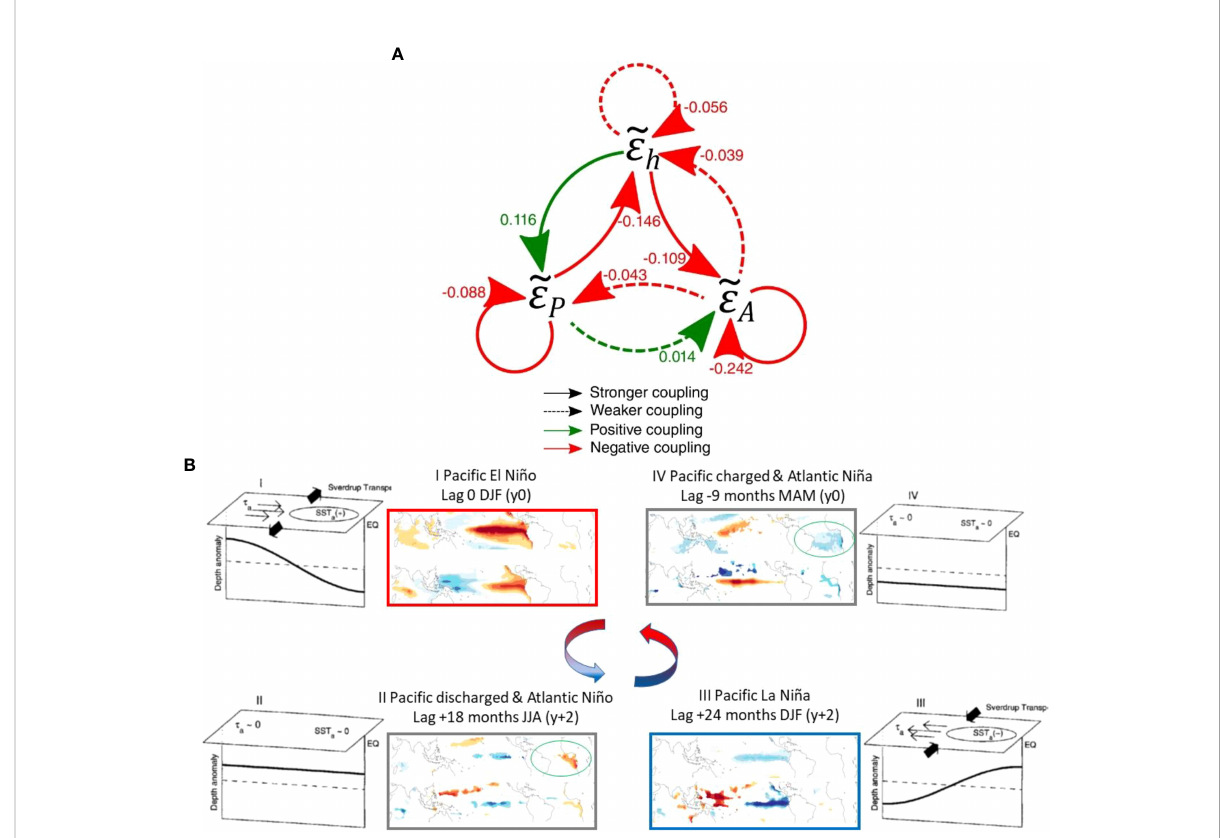
FIGURE 10 ENSO-Atlantic coupling. (A) Relations between Paci fi c thermocline depth anomaly e h , Paci fi c temperature anomaly e P , and Atlantic temperature anomaly e A found for the three-variable ENSO-Atlantic ReOsc+ model (Eq. 1 fi tted as explained in Section 2.3). (A) Arrows and numbers indicate the couplings between the three variables of the model during the period 1971-2000 obtained for the SODA reanalysis, see Table 4. Tildes above epsilons indicate adimensionalization, i.e., ~ ϵ j = ϵ j = S j , where S j is the characteristic amplitude (=standard deviation) of the anomalies e k The couplings are the dimensionally homogenized coupling coef fi cients ~ a jk = a jk · S k = S j (units of month -1 ). Solid arrows indicate stronger couplings and dashed arrows weaker couplings. (B) Idealized schematic of the El Niño – La Niña oscillation (modi fi ed from Jin, 1997 and Meinen and McPhaden, 2000) together with the regression maps of Nino3 index with real data for the period 1970-2000. In the schematic, thermocline depth anomaly is relative to the time mean structure along the equator. Dashed line indicates zero anomaly; shallow anomalies are above the dashed line and deep anomalies are below the dashed line. Thin arrows and symbol t represent the anomalous zonal wind stress; bold thick arrows represent the corresponding anomalous Sverdrup transports. SST is the sea surface temperature anomaly. Oscillation progresses anti- clockwise around the panels following the roman numerals; Panel I represents El Niño conditions, Panel III indicates La Niña conditions. Panel II and IV represent the phase of equatorial Paci fi c discharge and charge, respectively. The colored arrows represent the adjustment processes timing. The regression maps are for the SST (upper map) and OHC (lower map), which is the Ocean Heat Content integrated from surface up to 400m, representing the thermocline depth anomalies over the tropics for different lags. In the maps, red (blue) colors correspond to positive (negative) anomalies of the variables. El Niño and la Niña phases correspond to lag 0 (DJF year 0) and lag +24 months (DJF year +2), respectively. The phases of the equatorial Paci fi c discharge and charge correspond to lag -9 (MAM year 0) and lag +18months (JJA year +2) and appear covariant with the development of Atlantic Niña and Niño, respectively (marked with a green